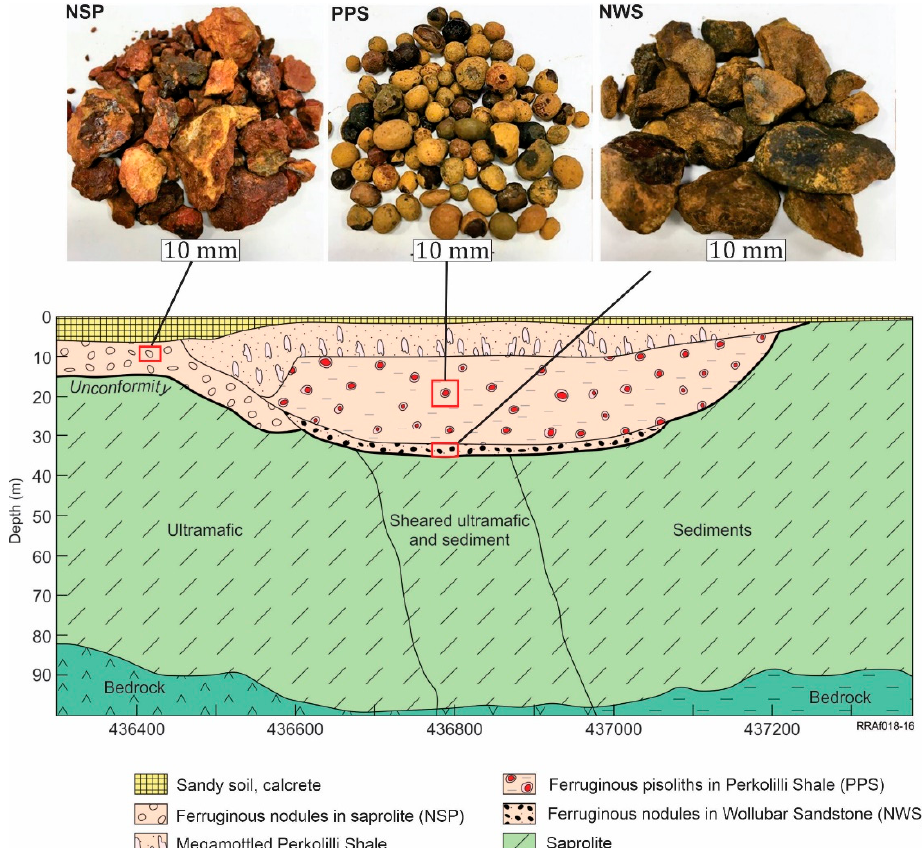
Figure 5. Regolith cross-section showing vertical and lateral variations in regolith units (including ferruginous materials) at the Garden Well Au deposit. Photographs of ferruginous nodules and pisoliths formed in the Perkolilli Shale (PPS), the Wollubar Sandstone (NWS) and saprolite (NSP) are also shown. Saprolite is developed on ultramafic, sheared ultramafic and sediments.